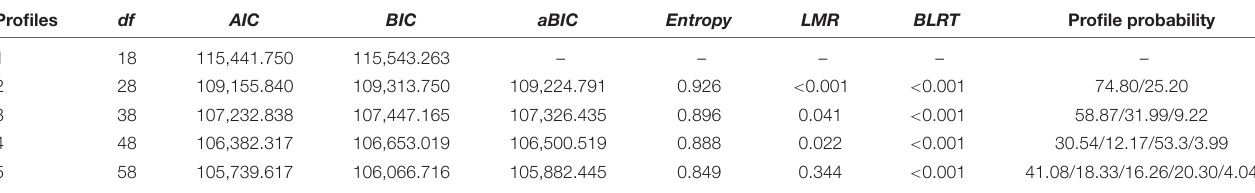
TABLE 2 | Fitting information was analyzed by latent categories of parenting